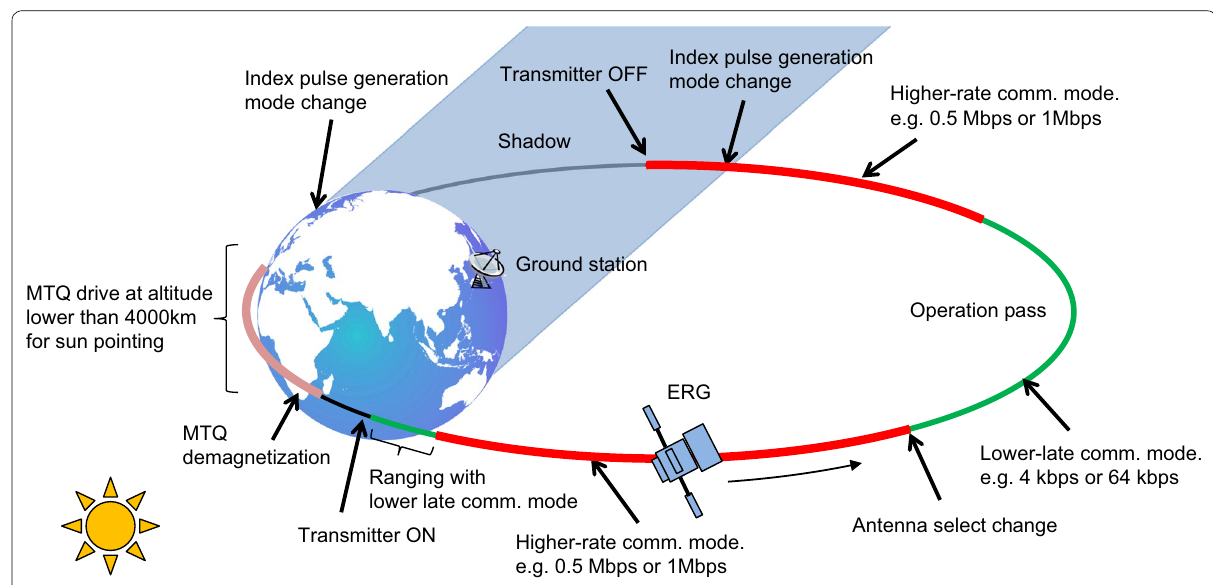
Fig. 17 Image of the operation of the ERG satellite in a highly elliptical orbit. A significant amount of mission data is recorded when space storms or other space events occur. Therefore, most of the long‑pass window around the apogee above Japan is used to downlink the mission data at a high speed of 0.5 or 1 Mbps via S‑band